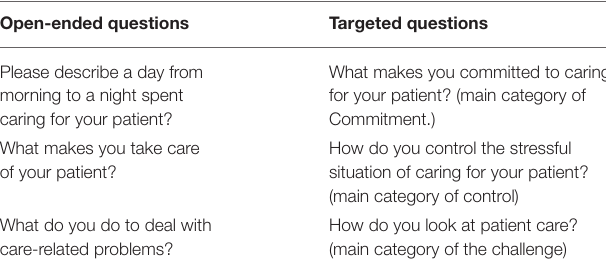
TABLE 2 | List of pre-interview open-ended and targeted